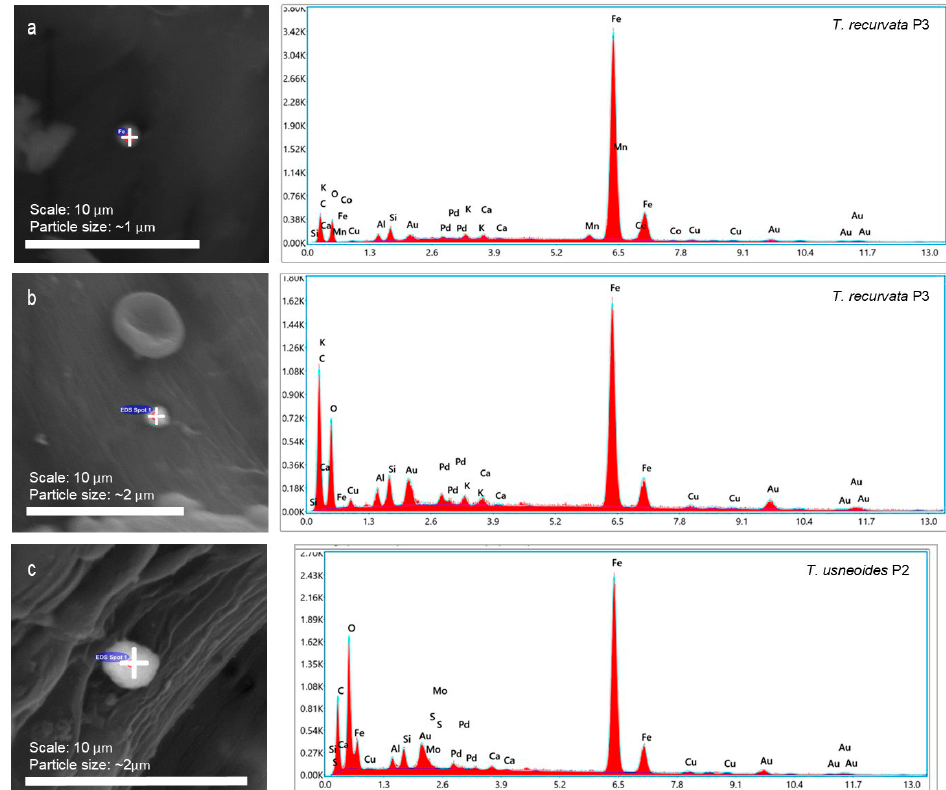
Figure 3. SEM-EDS analysis. ( a , b ) Spherical particles of ~1 and 2 µ m in T. recurvata from P3. ( c ) Spherule of ~2 µ m in T. usneoides from P2. The elemental composition of analyzed particles (cross) is shown.